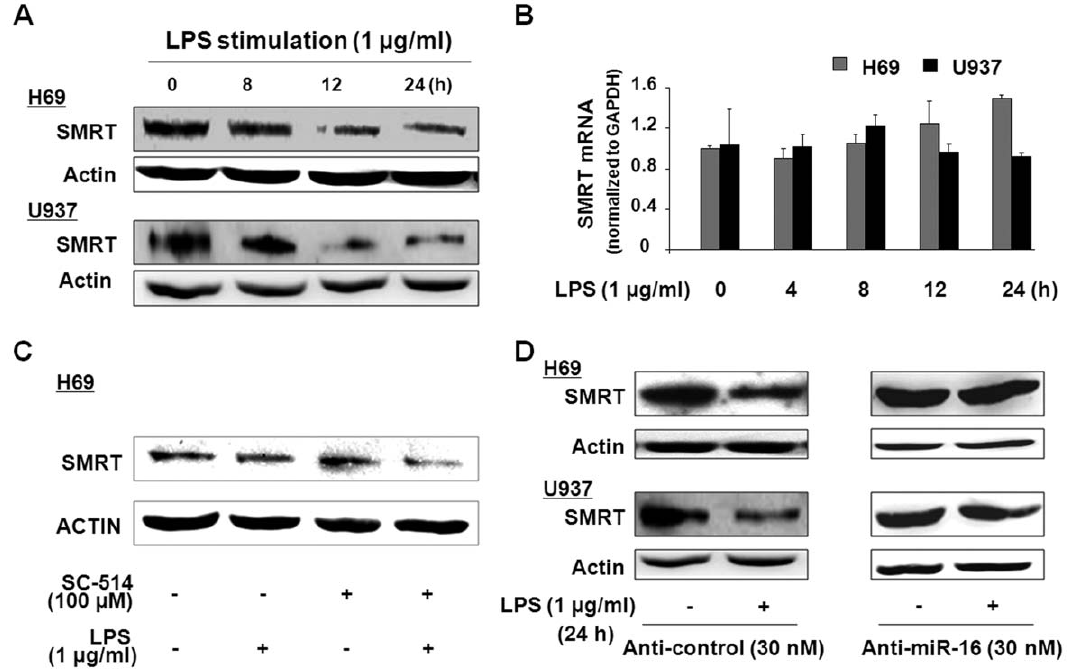
Figure 6. LPS stimulation decreases SMRT expression by upregulating miR-16. (A) and (B) H69 and U937 cells were exposed to LPS for up to 24 h, followed by Western blotting for the SMRT protein and real-time PCR analysis for SMRT mRNA. Downregulation of the SMRT protein (A), but not SMRT mRNA level (B), was detected in both H69 and U937 cells following LPS stimulation. (C) H69 cells were treated with LPS for 24 h in the presence or absence of SC-514 (100 m M), followed by Western blot for SMRT protein. SC-514 showed no significant effects on LPS - induced decrease of SMRT. (D) Effects of anti-miR-16 on LPS-induced downregulation of the SMRT protein in H69 and U937 cells. Cells were transfected with anti- control (30 nM) or anti-miR-16 (30 nM) for 24 h and cultured for an additional 24 h in the presence or absence of LPS (1 m g/ml). Representative blots from at least three independent experiments are shown. b -actin was blotted as a loading control.